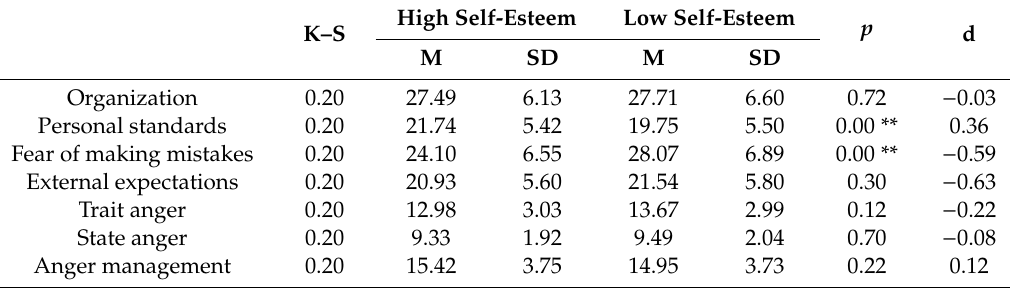
Table 2. Descriptive statistics of the sample.